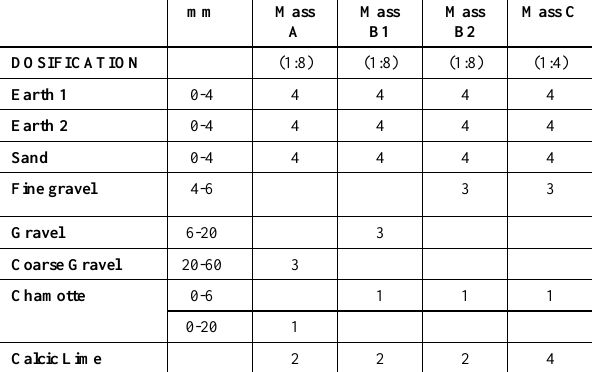
Table 1. Mass formulations in the west wall of the